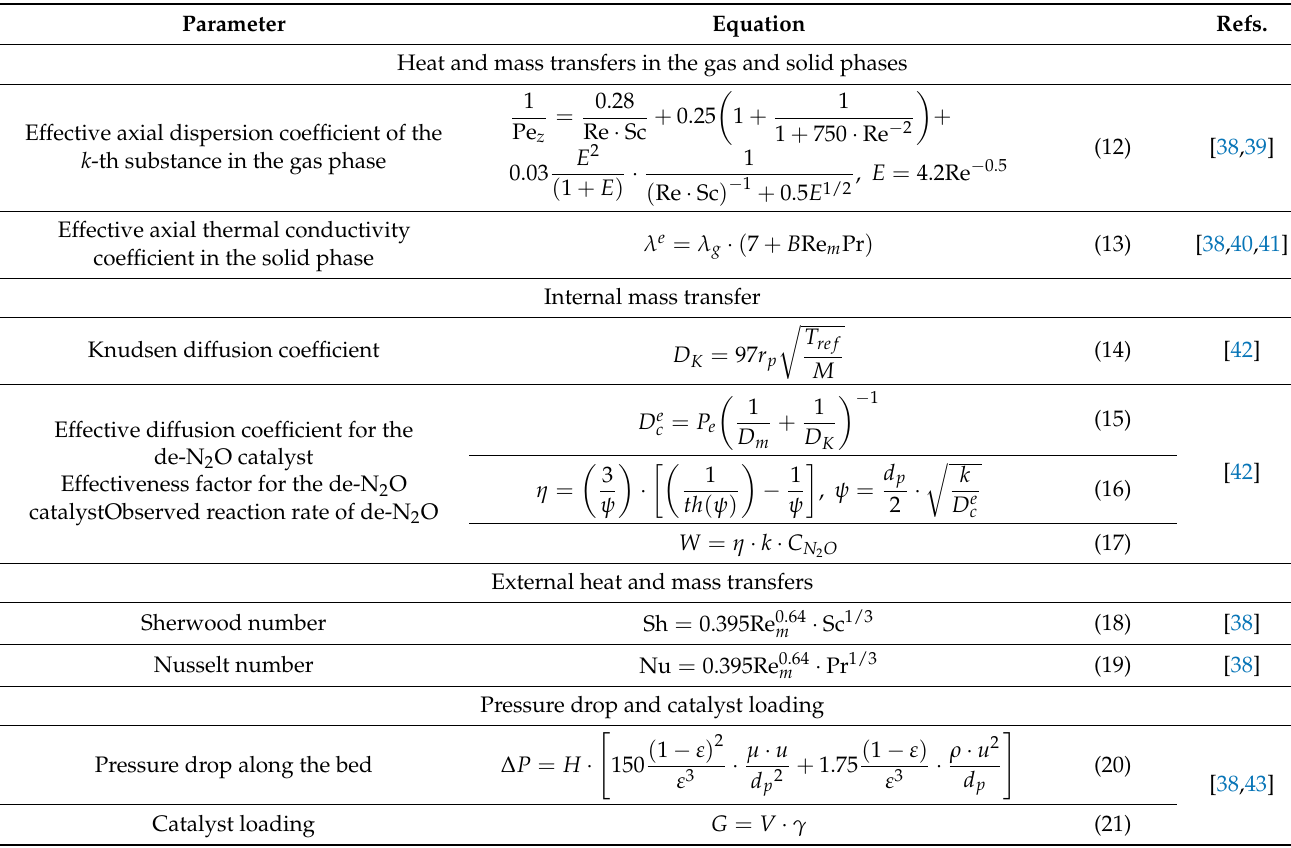
Table 5. Correlations for calculating model parameters.